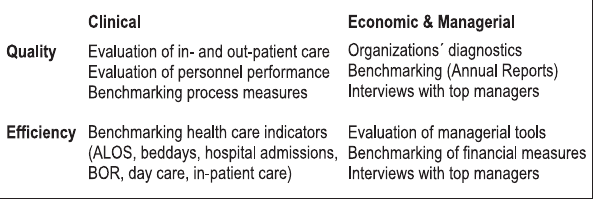
Fig. 2 . Matrix of methods